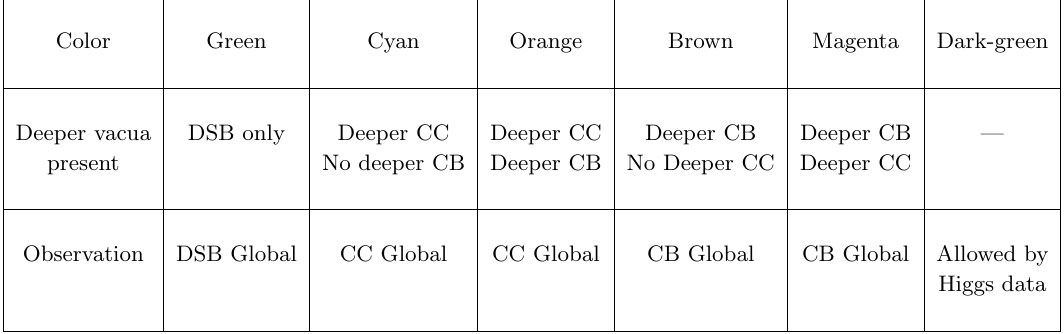
Table 1 . Color code used in (cid:12)gures 4 and 5 to indicate the presence of minima deeper than the DSB vacuum, their nature (CC or CB) and the one that is the global minimum of the potential.